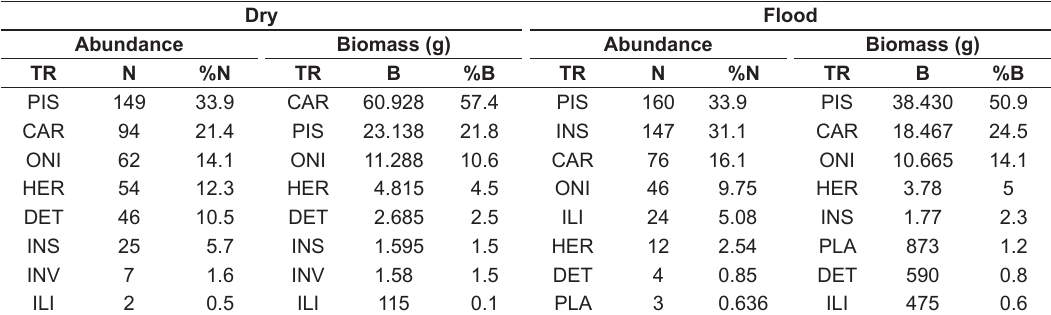
Figure 4. Dissimilarity of abundance of trophic groups in the dry and flood seasons. Table 3. Data of numerical abundance (N), abundance percentage (%N), biomass (B) and biomass percentage (%B) for each trophic rank (TR) (CAR=Carnivores, DET=Detritivores, HER=Herbivores, ILI=Iliophagous, INS=Insectivores, INV=Invertivores, ONI=omnivores, PIS=piscivores, PLA=planktivores) during dry and flood seasons in the Urucu River, municipality of Coari - AM /